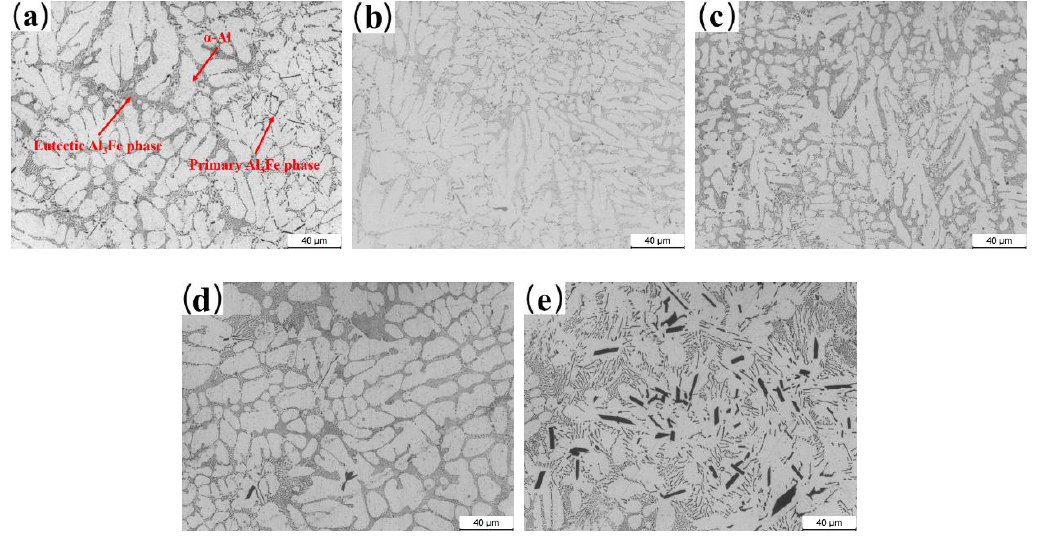
Figure 3. Microstructure of the Al-2Fe alloys modified with different contents of Co in the as-cast state: ( a ) Co-free; ( b ) 0.1%; ( c ) 0.3%; ( d ) 0.5%; ( e ) 0.8%.